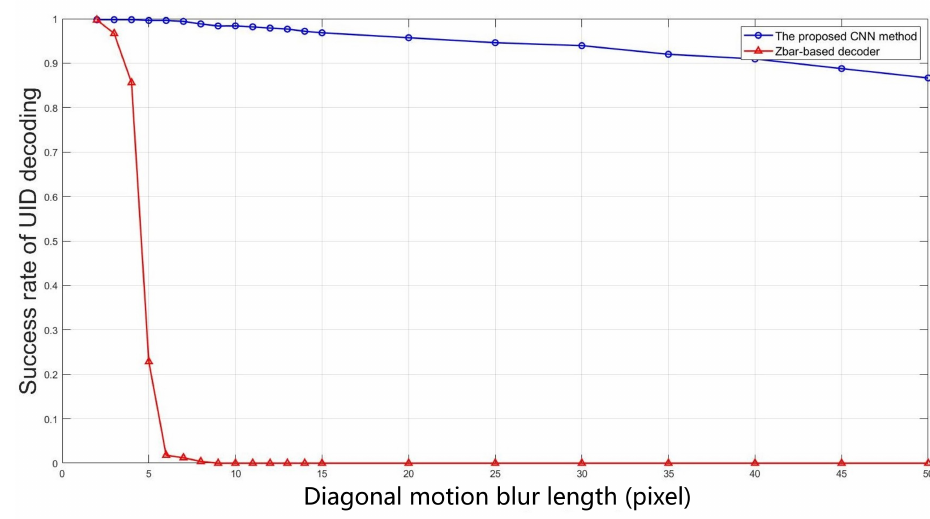
Figure 11. Success rate of UID decoding for diagonal motion-blurred images using the proposed BN-CNN model versus that using the Zbar-based decoder.